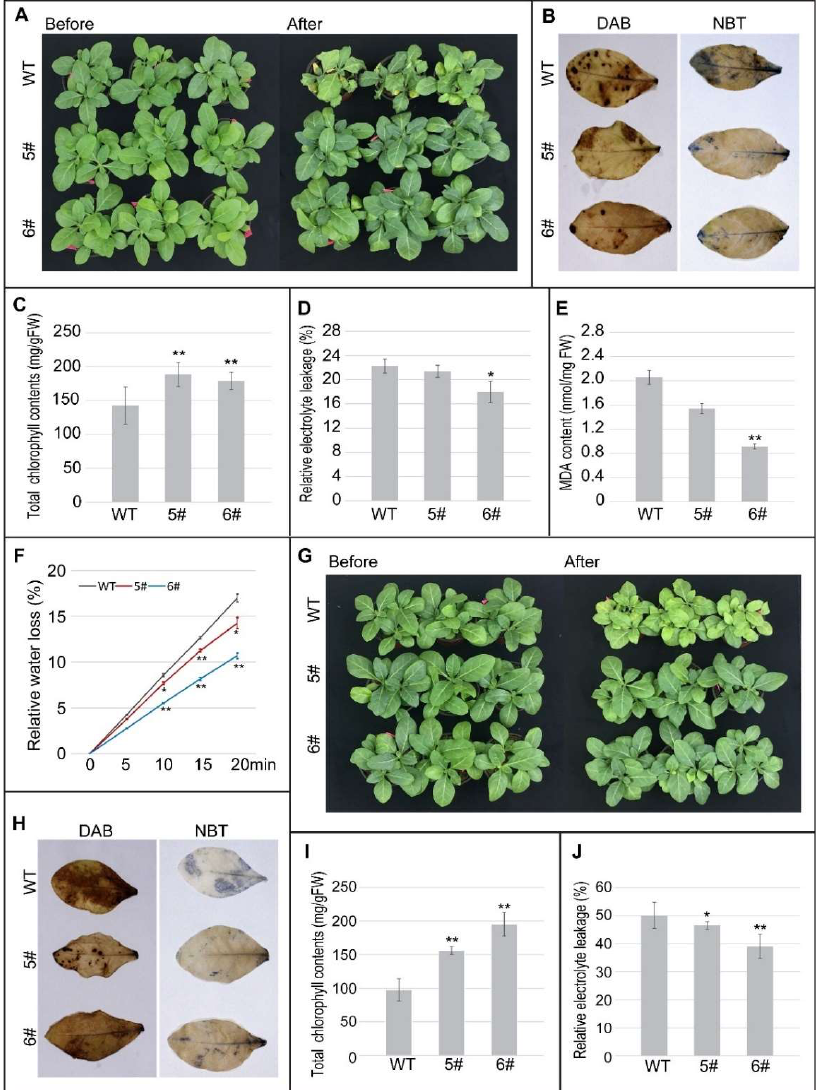
Figure 8. Overexpression of MdWRKY70L conferred enhanced drought and salt stresses tolerance in transgenic tobacco plants. ( A ) Phenotypes of 5-week-old seedlings withholding water for 10 days; ( B ) DAB and NBT staining after drought stress; ( C ) Chlorophyl contents; ( D ) The REL; ( E ) The MDA content; ( F ) Relative water loss; ( G ) Phenotype of 5-week-old seedlings after salt stress; ( H ) DAB and NBT staining after salt stress; ( I ) The chlorophyll content; ( J ) The REL. Asterisks represent significant difference between OE and WT lines (* p < 0.05, ** p < 0.01).